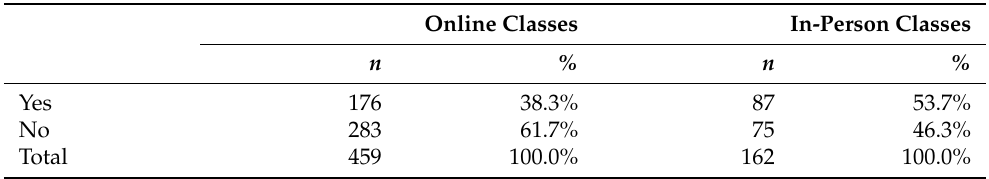
Table 10. Do you think universities need to introduce policies that limit students’ use of digital devices during class? Online Classes In-Person Classes